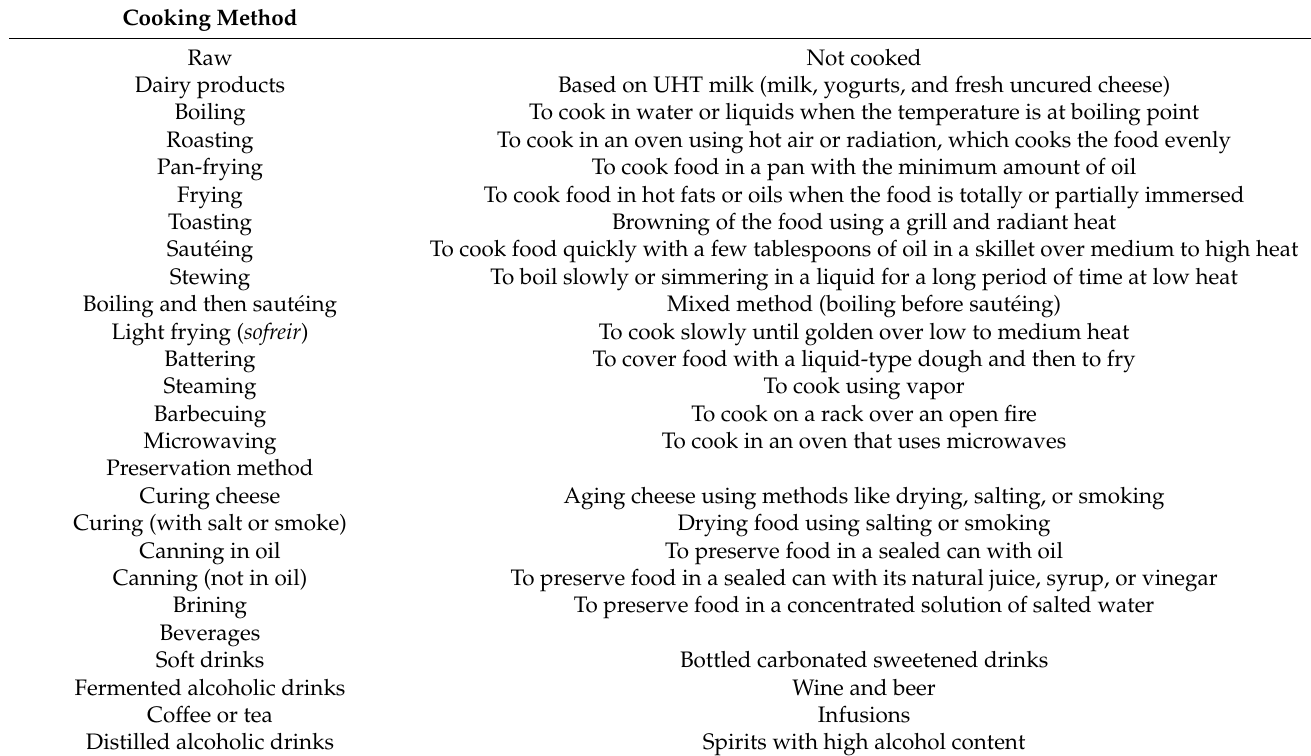
Table A1. Cooking and food preservation